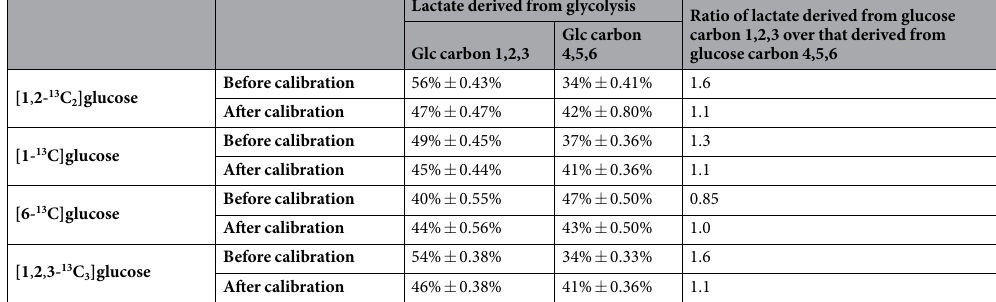
Table 5. Percentage of lactate isotopomers and isotopologues (mean ± SD, n = 12) generated by 4T1, traced by [1,2- 13 C 2 ]-, [1- 13 C]-, [6- 13 C]- and [1,2,3- 13 C 3 ]glucose before and after calibration. Percentage of lactate isotopomers and isotopologues derived from [1,2- 13 C 2 ]glucose is calibrated using 1.5 ([2,3- 13 C 2 ]lactate VS lactate, the right panel of Fig. 5A). Percentage of 13 C-labeling lactate derived from [1- 13 C]glucose and [6- 13 C] glucose is calibrated using 1.2 ([3- 13 C]lactate VS lactate, the right panel of Fig. 5C). Percentage of 13 C-labeling lactate derived from [1,2,3- 13 C 3 ]glucose is calibrated using 1.4 ([U- 13 C]lactate VS lactate, the right panel of Fig. 5D). The data before calibration are from Tables 2 and 4.